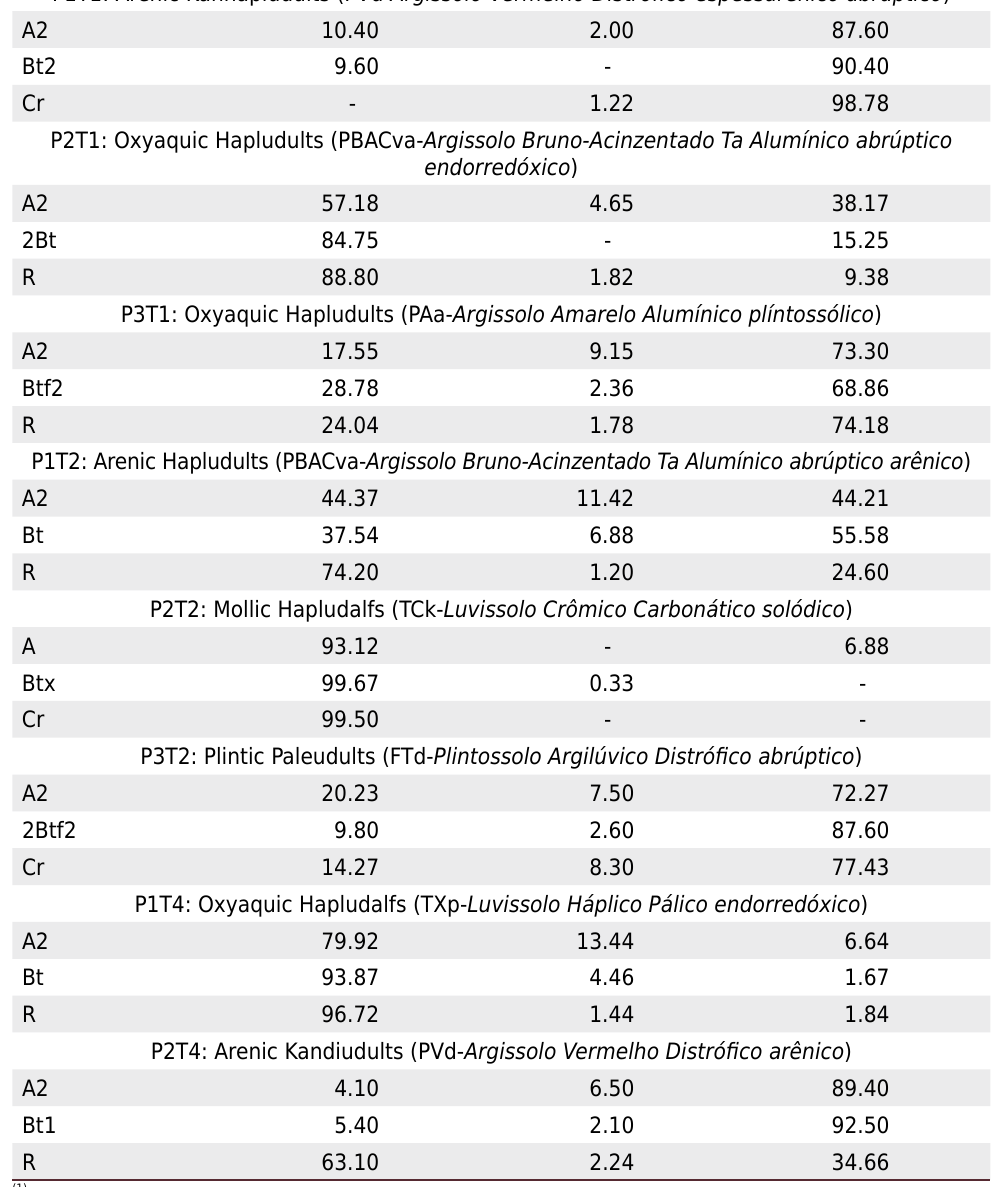
(1) Percentage obtained from the relation between the areas of the peaks of the clay minerals considered: 2:1HE: 2:1 (smectite or vermiculite) and/or interstratified 2:1 and/or EHE and/or VHE; Mi/Il: mica (illite); Ct/C-E: kaolinite and/or interstratified